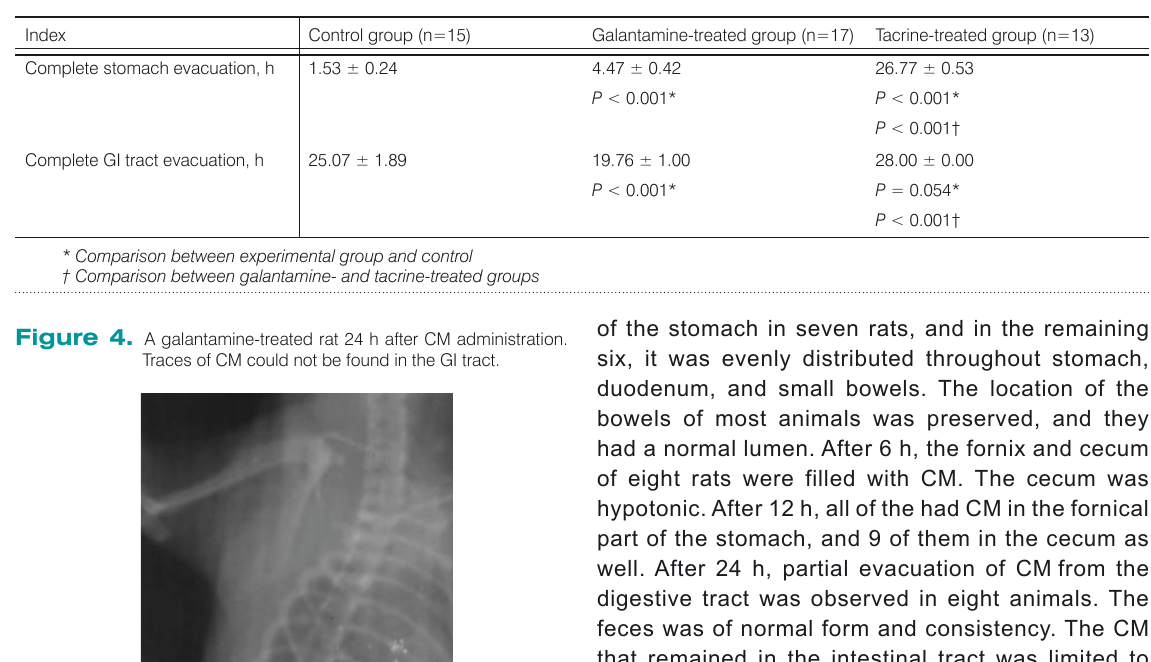
Table 1. Kinetics of CM evacuation in the rat gastrointestinal